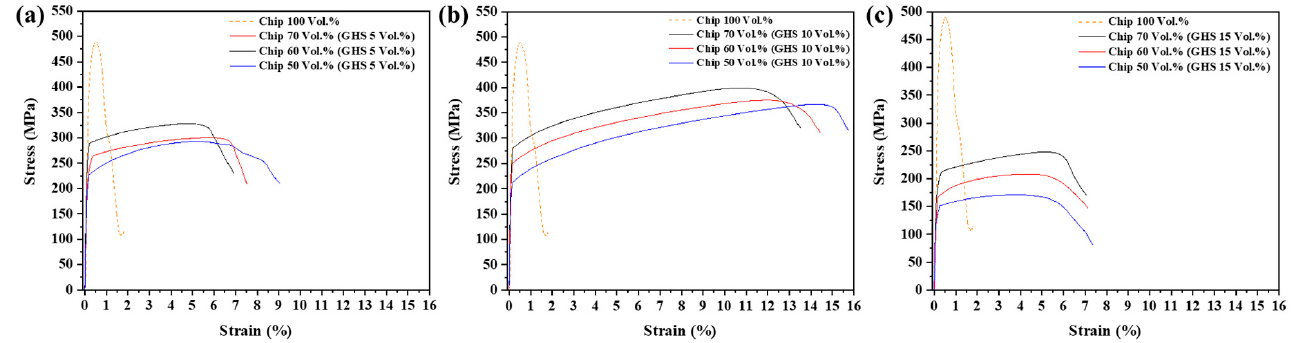
Figure 11. Compressive stress-deformation curves for Al chip alloys and AlG foams: ( a ) Al(50, 60, and 70)G5; ( b ) Al(50, 60, and 70)G10; ( c ) Al(50, 60, and 70)G15. Table 7. Compressive properties of all